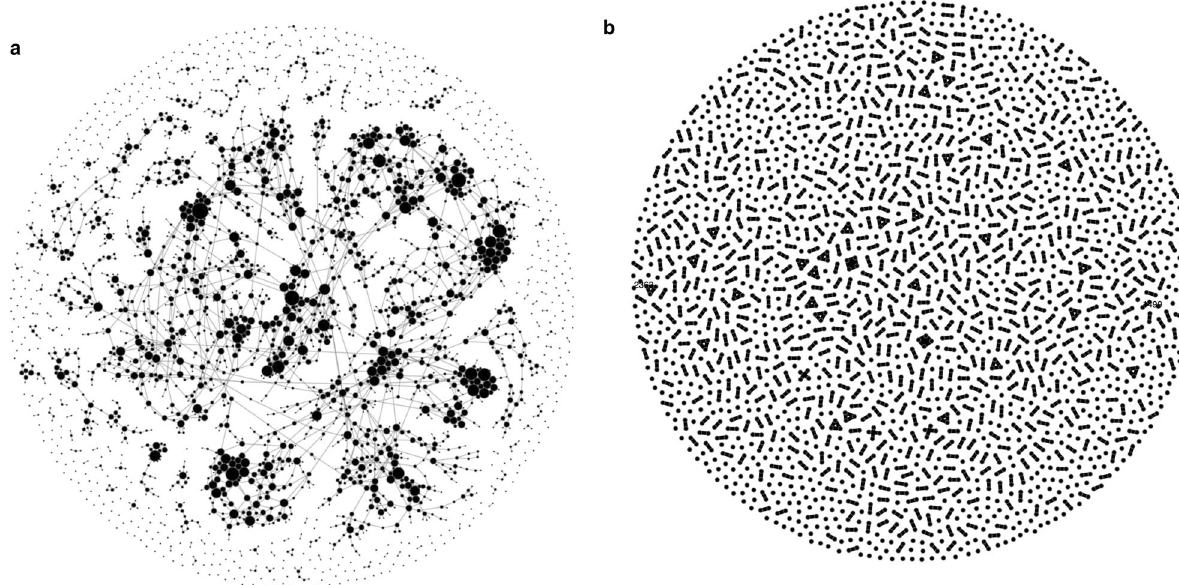
Figure 2. Shareability graph linking 3 200 travellers to 11,000 pooled rides feasible for them ( a ). Size of nodes is proportional to degree (number of travellers for shared rides and number of feasible rides for travellers). The graph structure includes a giant component and a high degree nodes, which may become a super-spreaders, as well as isolated peripheral nodes, where travellers either cannot find a feasible match or form a small, isolated communities from which virus will not outbreak. The actual matching of travellers to shared rides on a single day ( b ) has a substantially different structure. Here ( b ) nodes denote travellers, linked if they share a ride. Single dots are unmatched travellers riding alone, while lines, triangles and squares denote pooled rides of higher degree (2, 3 and 4, respectively). While the potential shareability ( a ) is densely connected, matching on a single day ( b ) is disintegrated. Each pooled-ride forms an isolated community (i.e. co-travellers within a single vehicle), with a clique of size bounded with vehicle capacity (four in our case). The virus will spread within each clique but will not reach beyond it on a given day. However, infected traveller may be assigned to a new ride on successive day, resulting with virus propagation beyond the single vehicle. Networks visualized with 34 newtulf